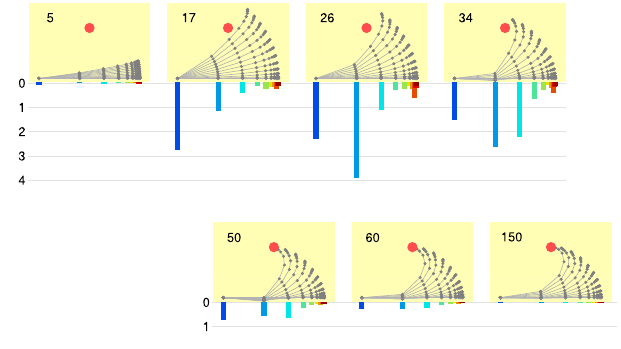
Figure 7. The arm motion at di(cid:636)erent stages of learning. The numbers next to the arm indicates the number of updates. The exploration magnitude per joint λ m is plotted as a bar graph below each arm.